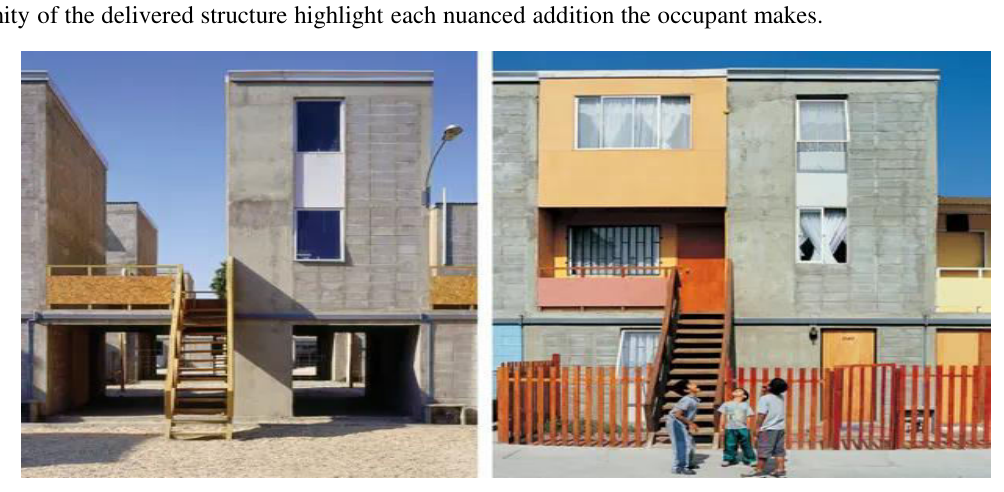
Figure 4: Occupant infill construction at Iquique. Theguardian.com,